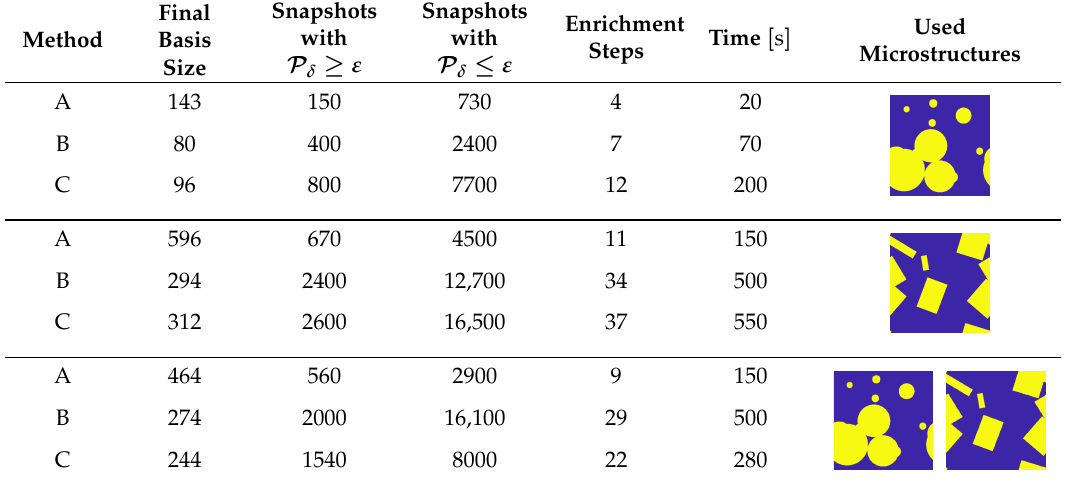
Table 1. Data of the unsupervised learning (incremental reduced basis (RB) identification) for the nine considered scenarios; the parameters ε = 0.025, n c = 100 and n a = 75 were used. Some numbers are rounded for easier readability.